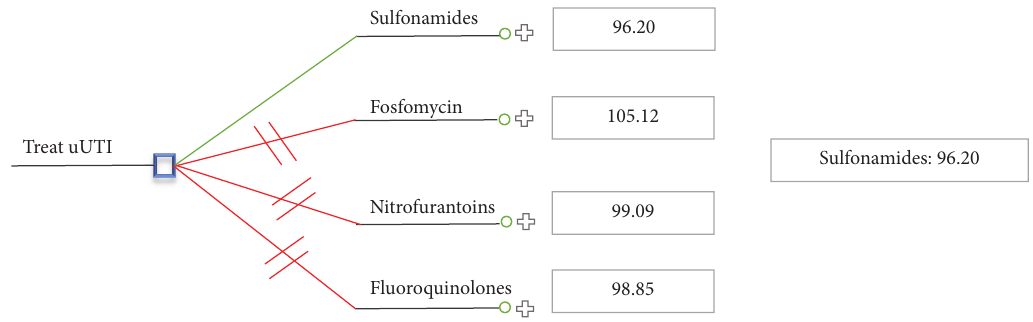
Figure 2: Cost-per-patient for treating uUTI in Ontario.